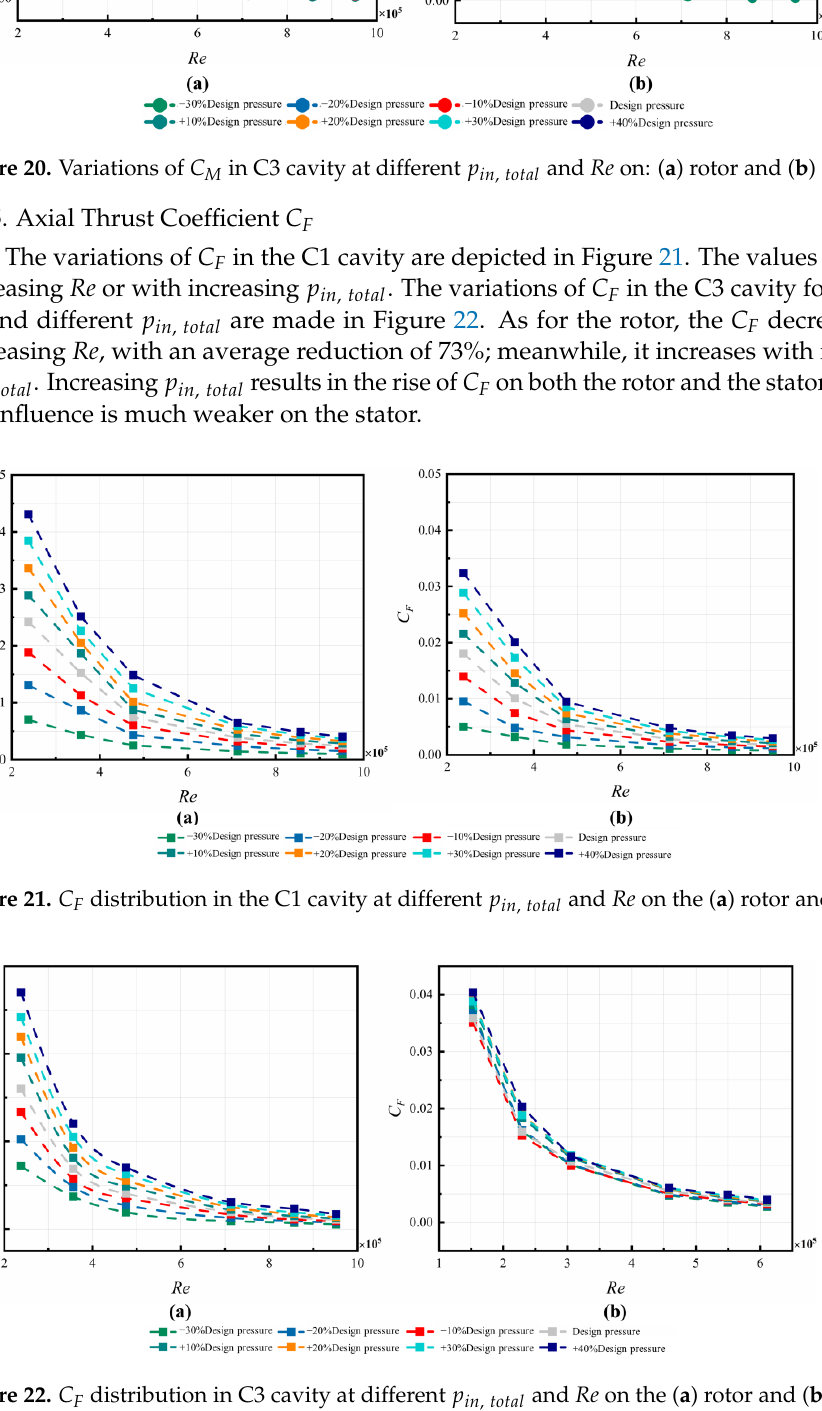
Figure 22. C F distribution in C3 cavity at different p in , total and Re on the ( a ) rotor and ( b )